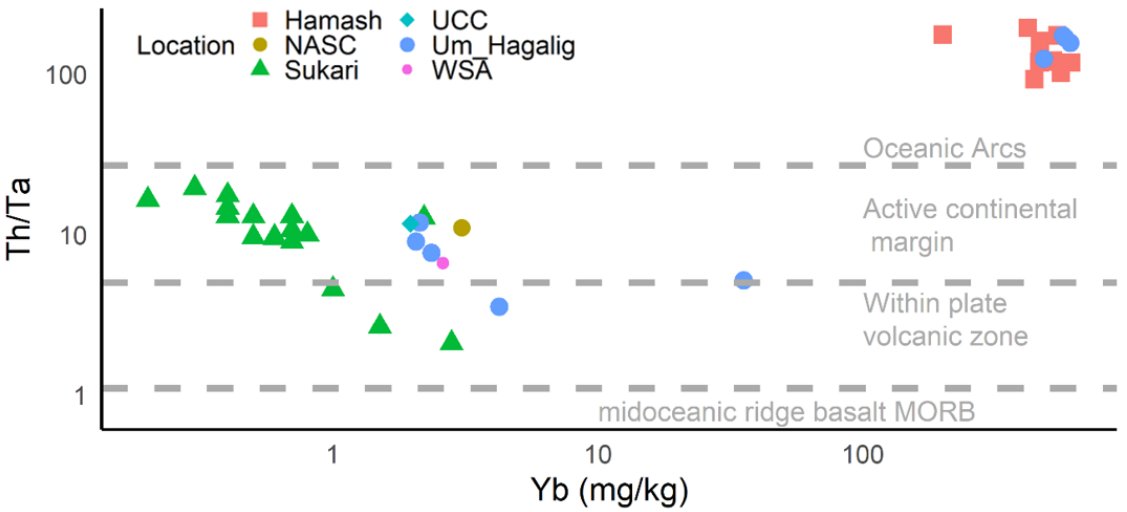
Figure 8. Th/Ta versus Yb relationship in which felsic volcanic rocks of mines are close to the fields of oceanic arc and active continental margin [47]. After Pearce, Harris, and Tindle